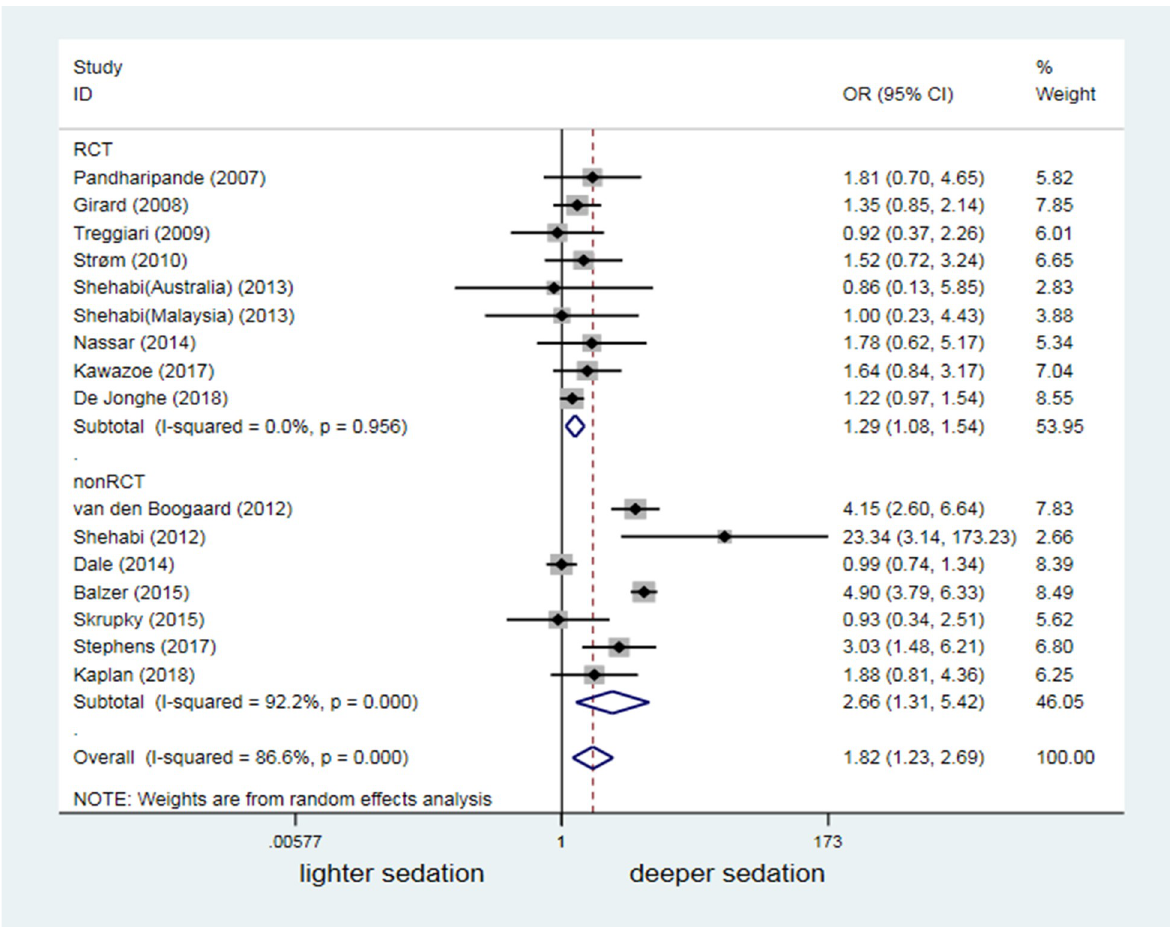
Fig 8. The impact of discrepancy in depth of sedation on